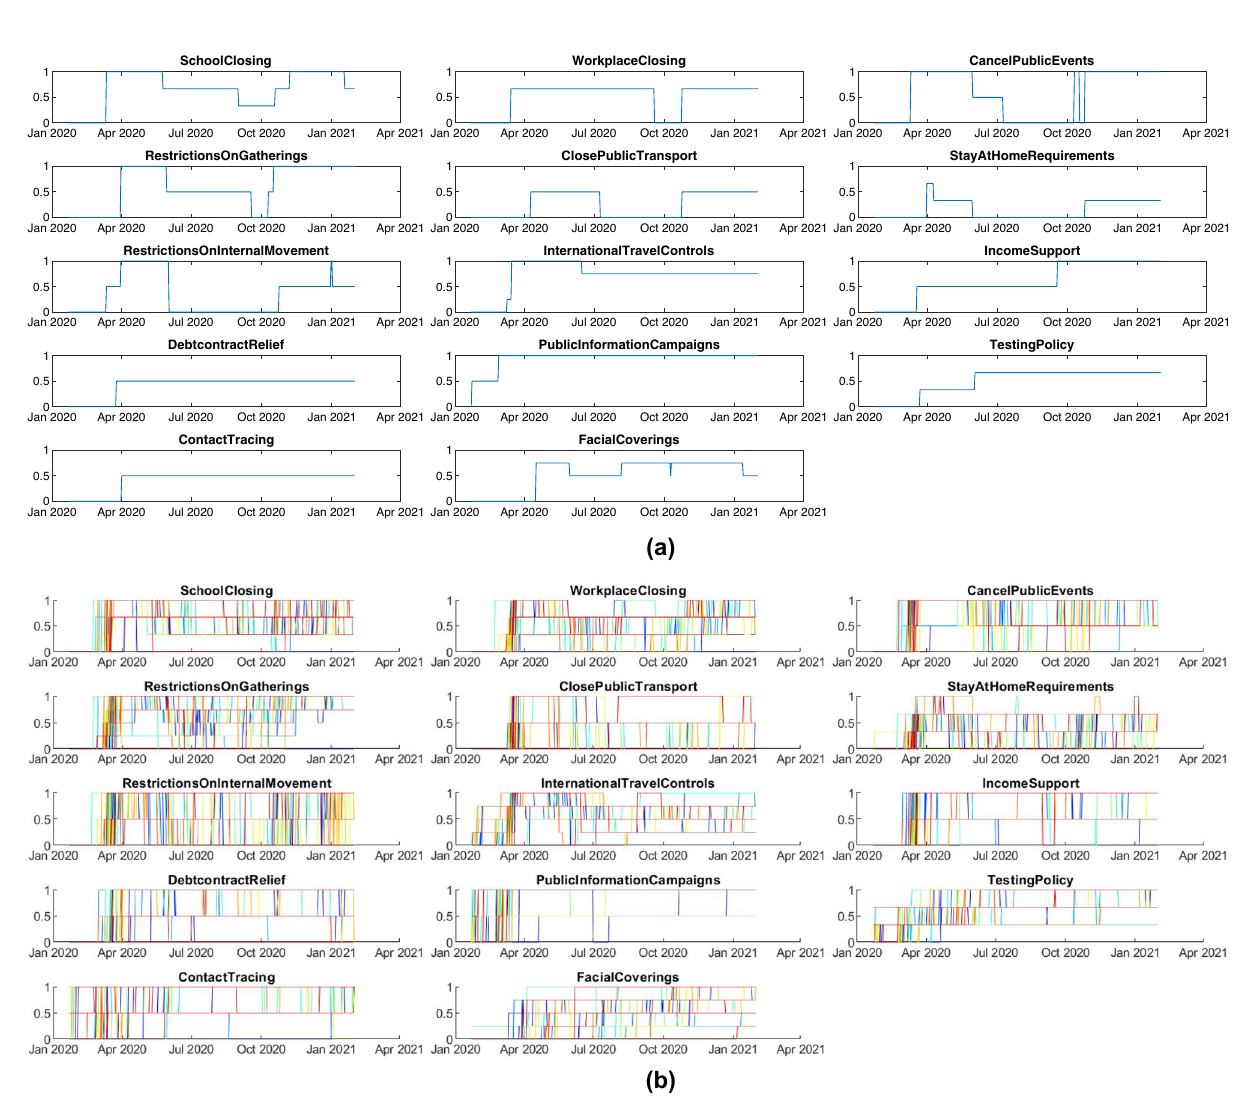
Figure 2. ( a ) Moments of enabling/disabling specific actions to prevent the spread of the COVID-19 pandemic in Poland. The enabling times are the same for debt contract relief and contact tracing, making them indistinguishable for the model. Several policies never reach their maximum level, which makes interpretation difficult. ( b ) Restriction functions for all European countries (each color represents a distinct country). Due to the large number of countries, the figure shown is only illustrative to demonstrate that the problem of indistinguishability of the impact of restrictions, observed for a single country, is now no longer relevant. Separate charts for individual countries can be seen in the Supplementary